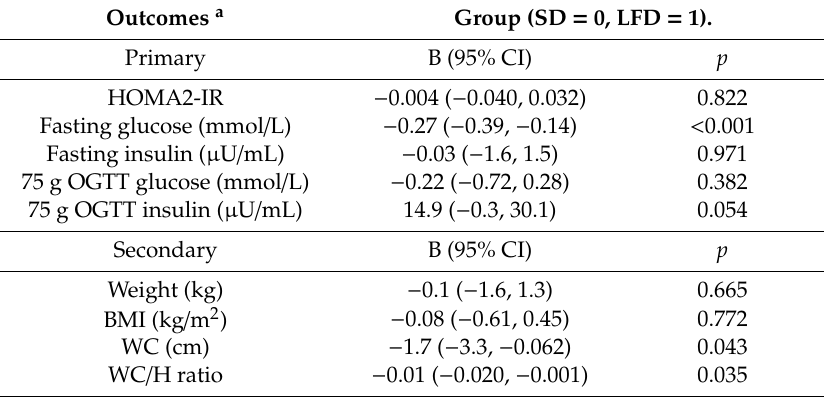
Table 6. Multiple linear regression models: di ff erences between week 24 and week 0 in primary and secondary outcomes as dependent and group as explanatory